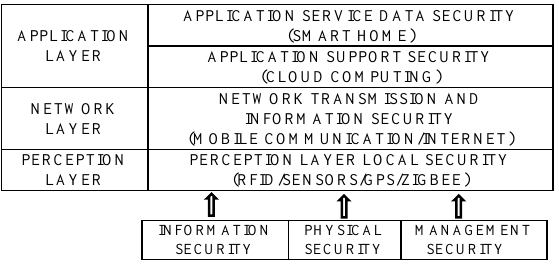
Figure 2 . Security Architecture of IoT